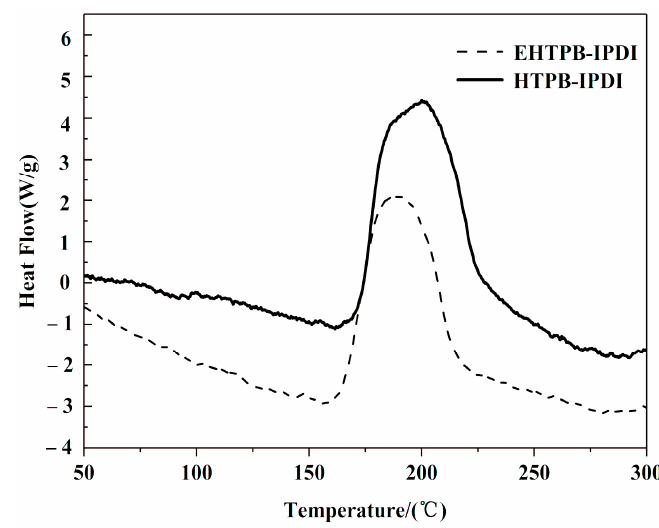
Figure 6. Non-isothermal DSC curves of the HTPB-IPDI system and HTPB-IPDI system a scanning rate of 5 °C min − 1 . Table 1. Data of the EHTPB-IPDI and HTPB-IPDI systems.